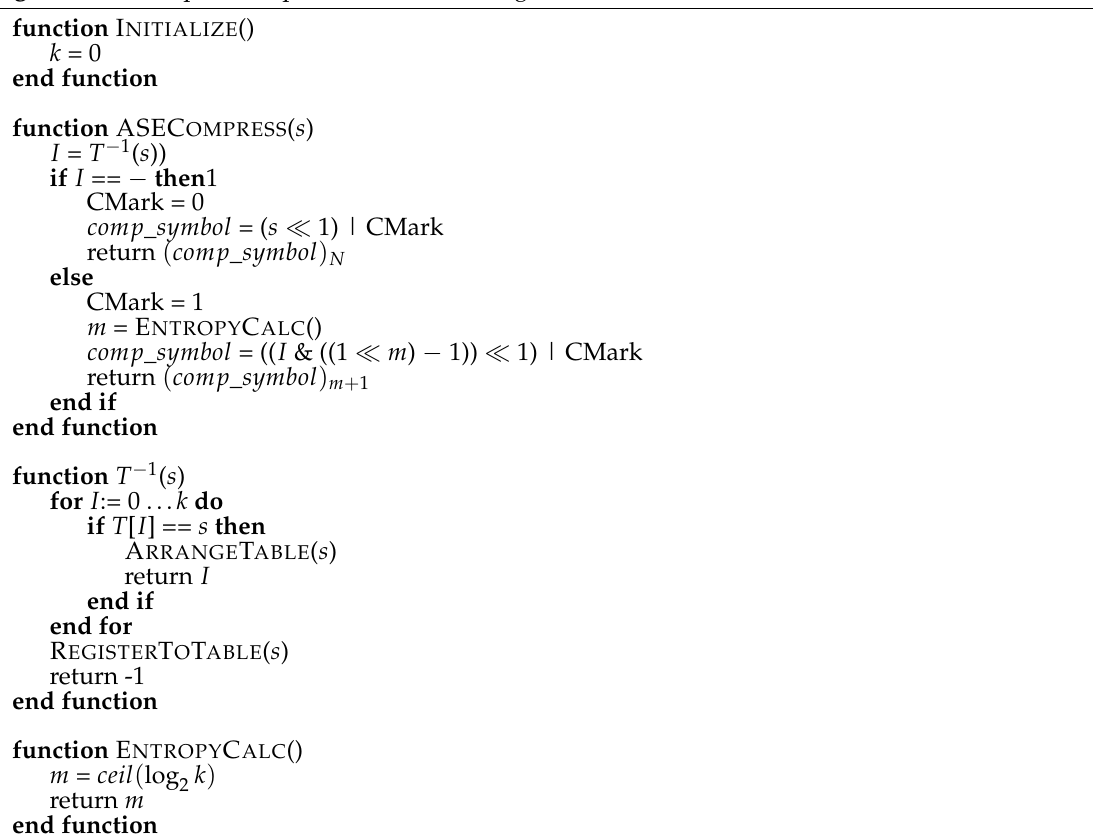
Algorithm 1 Compression process of ASE